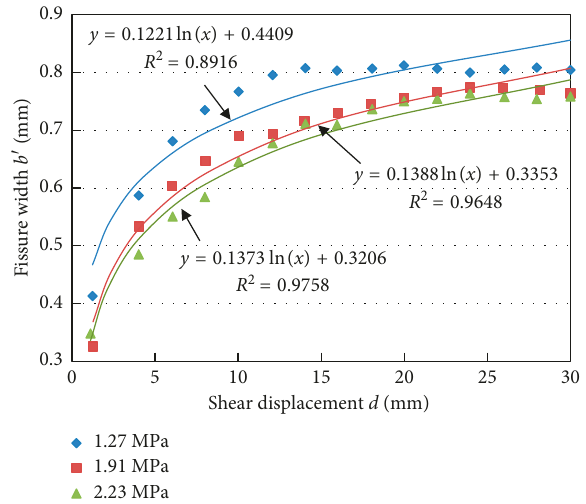
with increasing shear dis- ′